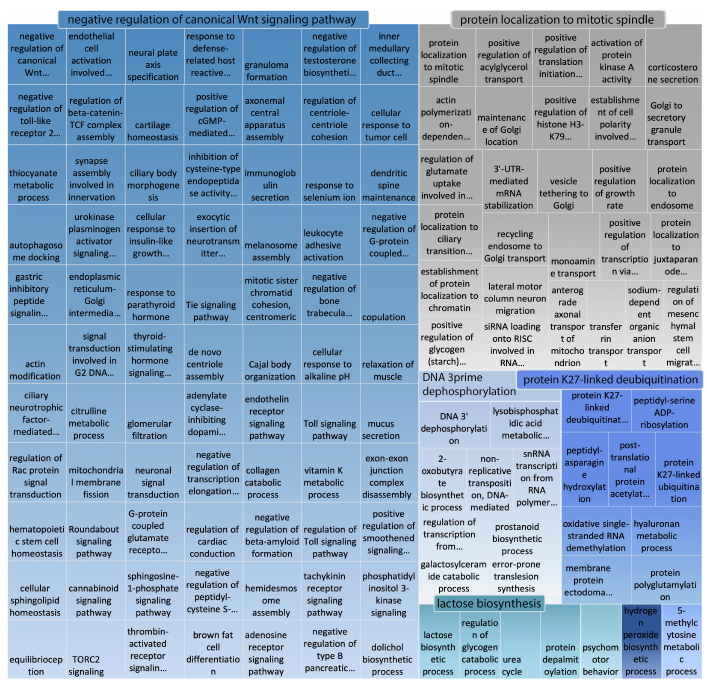
Figure 5. REVIGO representation of GO biological process terms (with PPV > 0.7) that are significantly enriched in disordered Camelus proteins. Disordered proteins are those containing at least one “long disordered region” based on DISOPRED